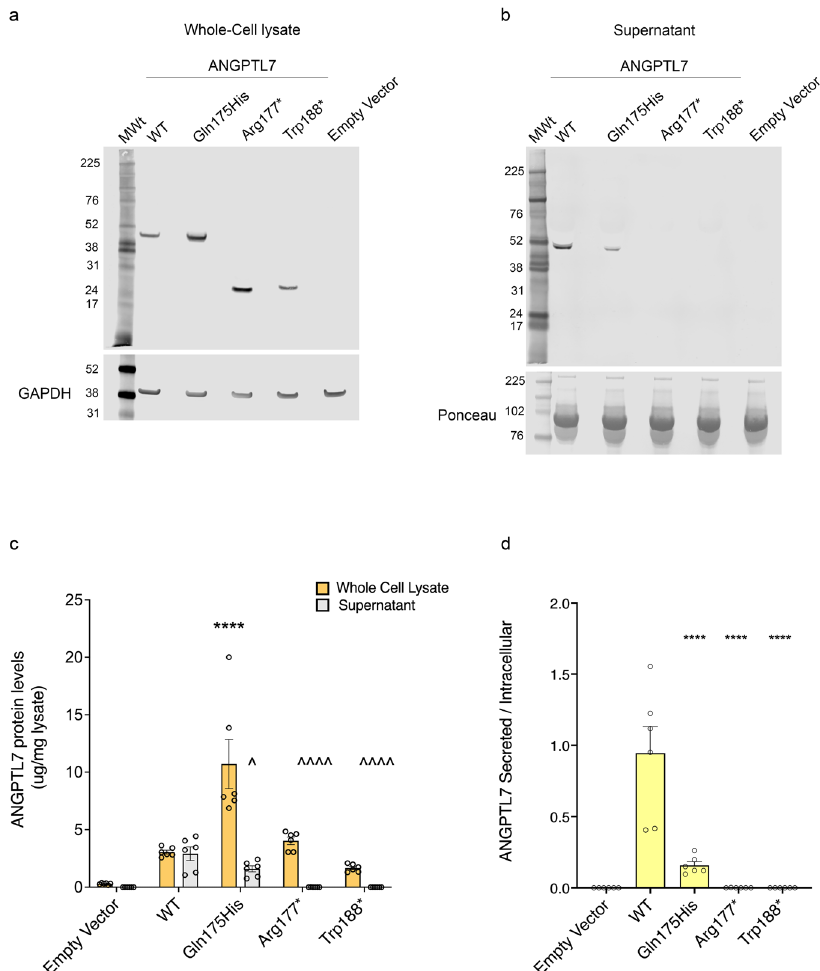
Fig. 4 Expression analysis of ANGPTL7 Gln175His, Arg177*, and Trp188* in a HEK293 cell line. a , b Western blotting shows intra- and extra-cellular protein levels of ANGPTL7 wild-type (WT), Gln175His, Arg177*, and Trp188*. c ELISA was run to quantify intra- and extra-cellular protein levels of ANGPTL7 WT, Gln175His, Arg177*, and Trp188* transiently transfected in HEK293 cells (whole-cell lysate was diluted 1:1,000; supernatant was